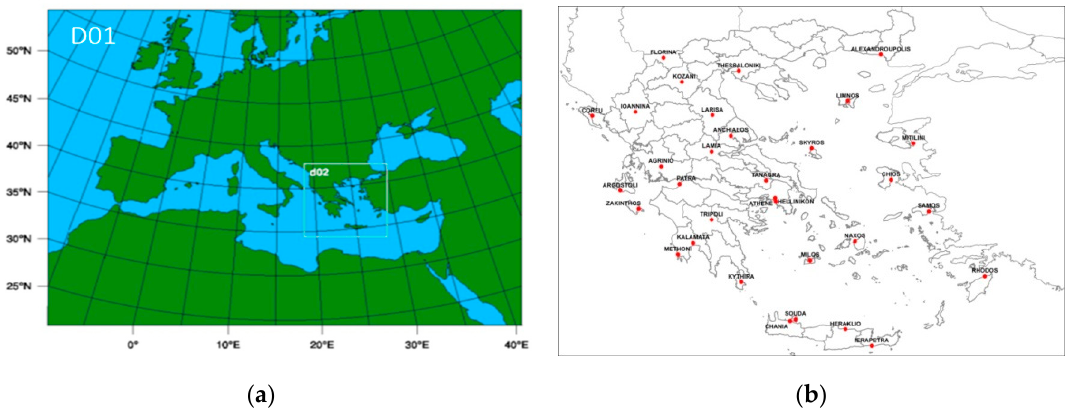
Figure 1. (a) Weather Research and Forecasting (WRF) model domains: D01 coarse domain with Figure 1. ( a ) Weather Research and Forecasting (WRF) model domains: D01 coarse domain with 20-km, 20-km, the innermost D02 domain covering the Greece. (b) Location of the selected observational the innermost D02 domain covering the Greece. ( b ) Location of the selected observational stations of stations of the Hellenic National Meteorological Service (HNMS). the Hellenic National Meteorological Service